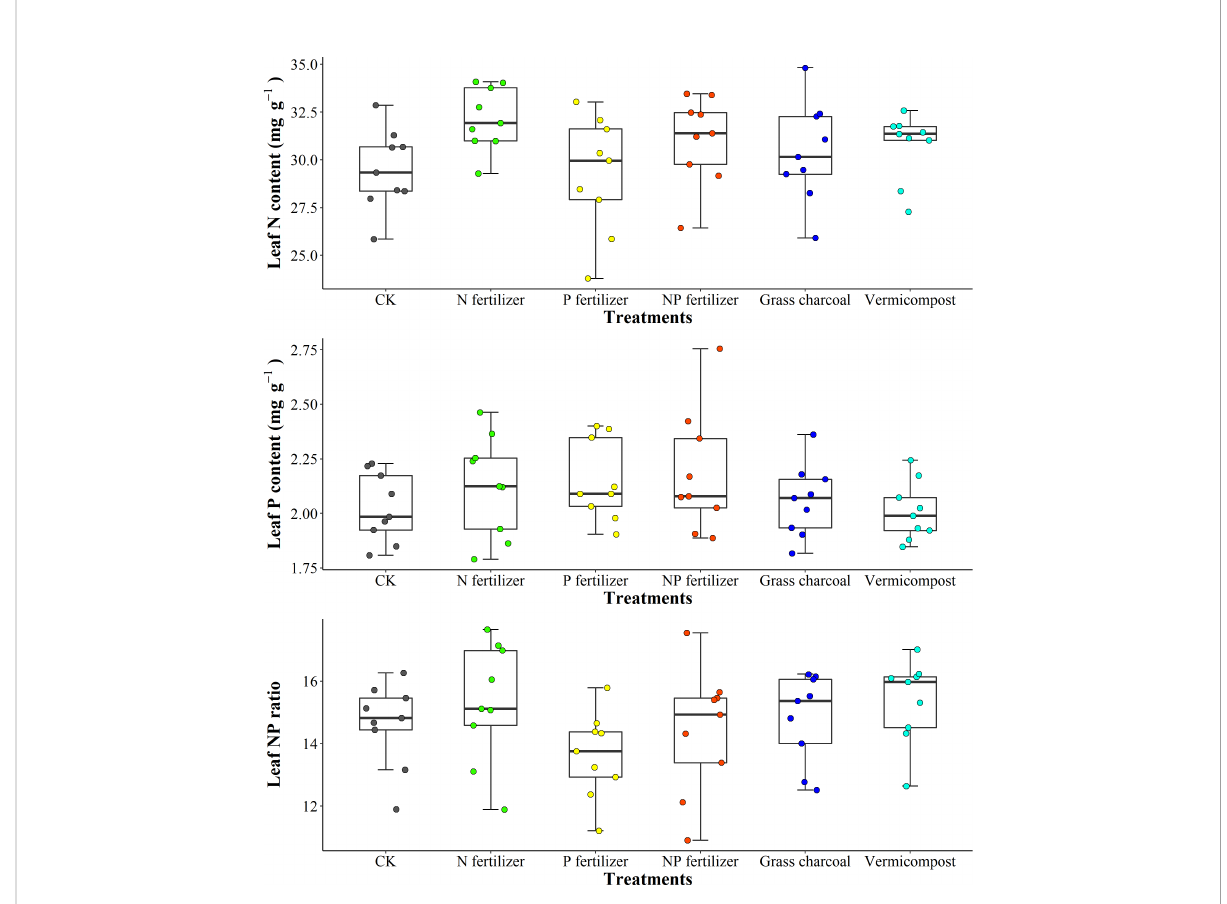
FIGURE 7 Effects of different soil fertility improvement measures on characteristics of leaf N and P of Acer catalpifolium